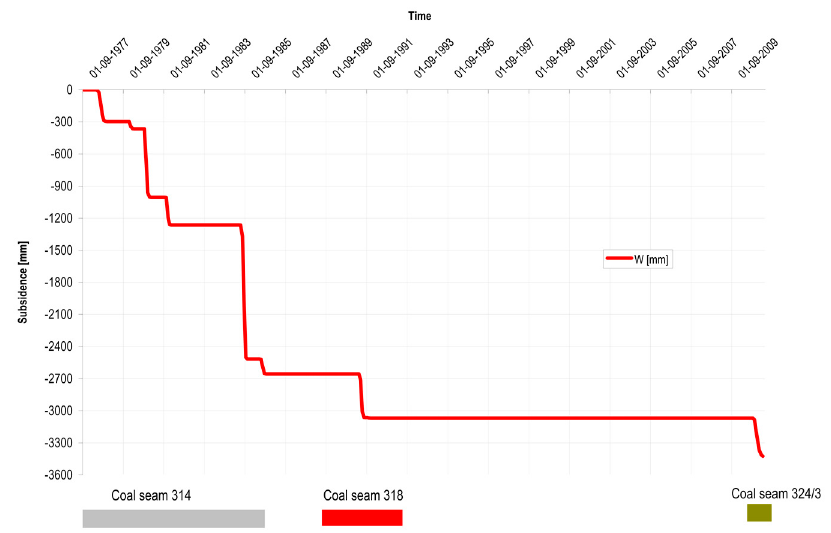
Figure 13. The course of the surface subsidence at the location of the discontinuous deformation over time.